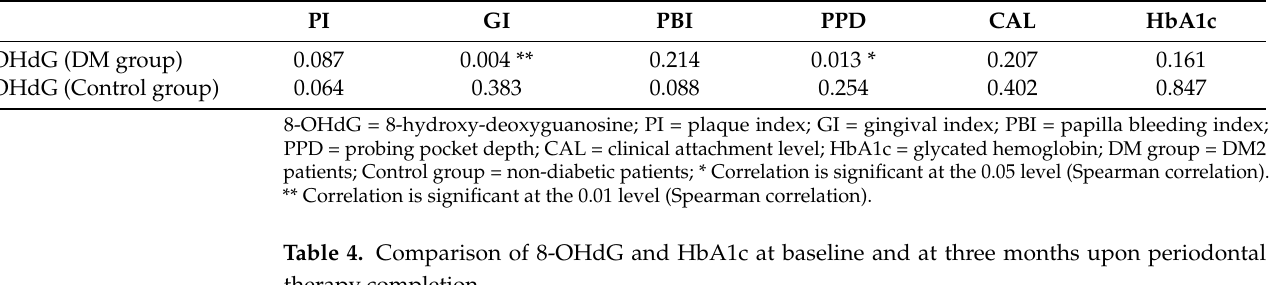
Table 3. Correlations between 8-OHdG and clinical parameters (PI, GI, PBI, PPD, and CAL) as well as HbA1c at baseline. PI GI PBI PPD CAL HbA1c